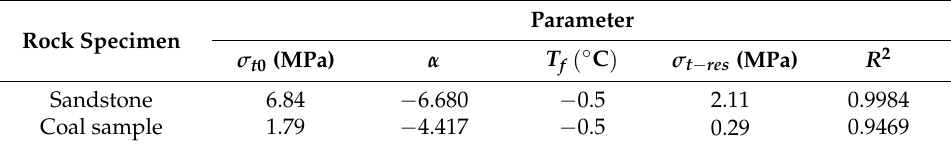
Table 2. Theory parameters (Equation (3)) for tensile tests.